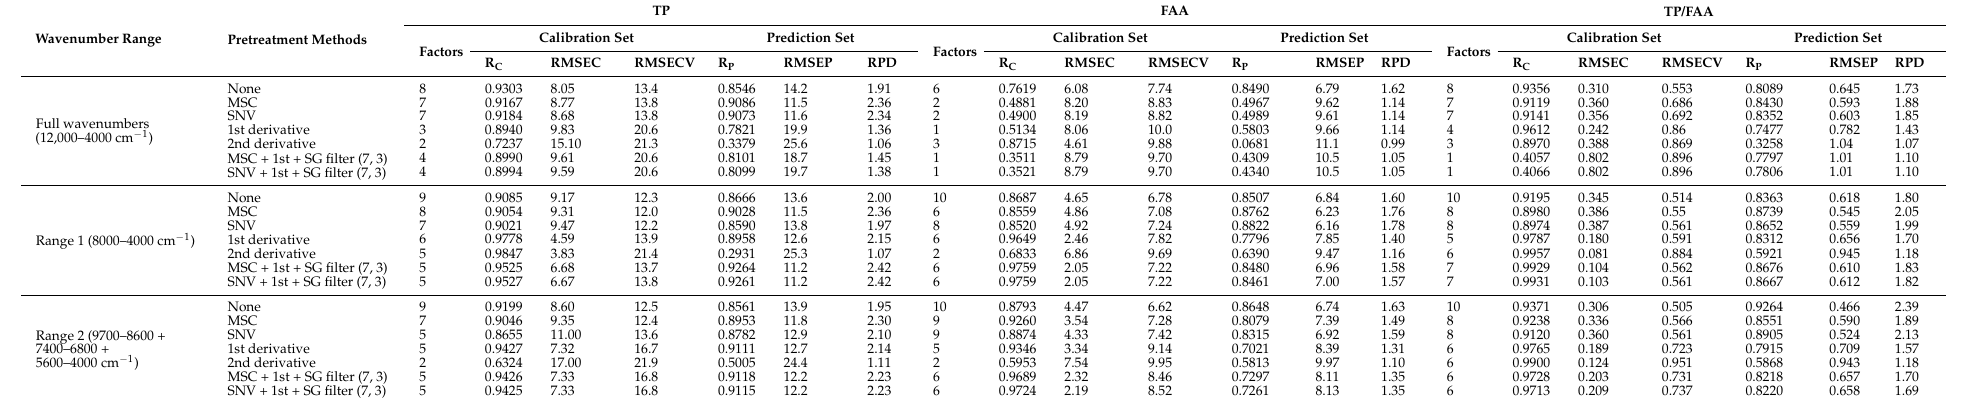
Table 2. The performance of partial least squares (PLS) models with different spectral preprocessing approaches for the prediction of total polyphenols content (TP), free amino acids content (FAA), and polyphenols-to-amino acids ratio (TP/FAA), based on different wavenumber ranges.